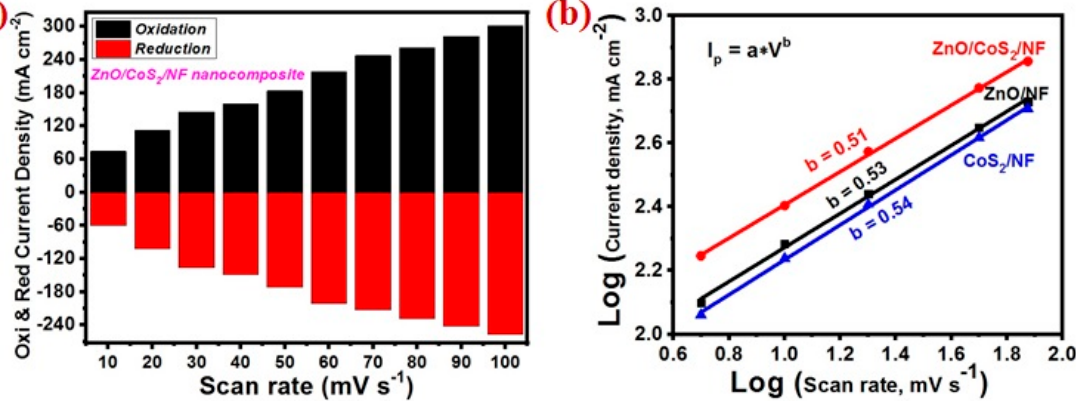
Figure 4. ( a ) Linear relationship of oxidation and reduction vs. scan rate for nanocomposite; ( b ) b values obtained from the log (i) vs. log (v) plot for the cathodic peaks of ZnO/NF, CoS 2 /NF, and ZnO/CoS 2 /NF nanocomposites.